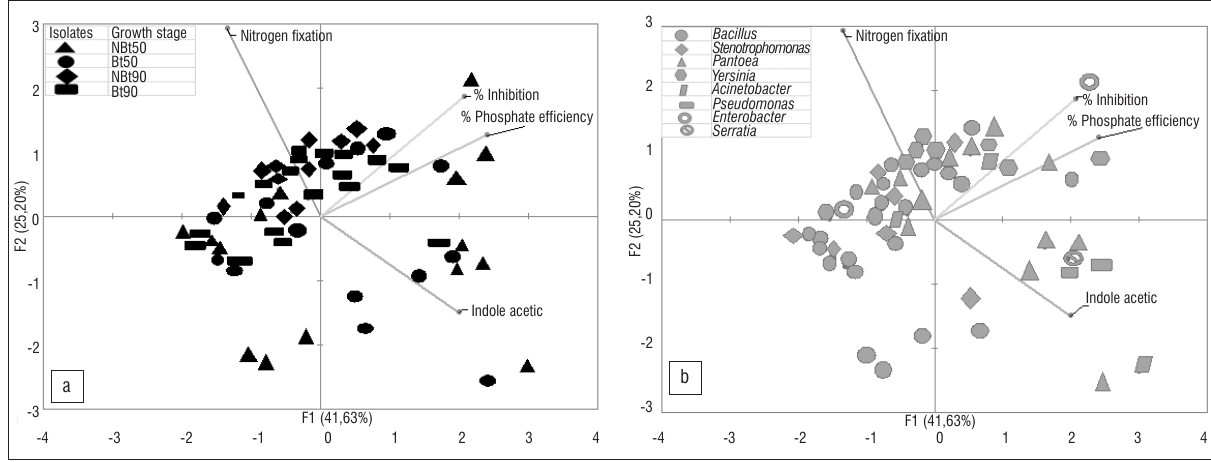
Figure 5: Clustering relationship between (a) endophytic isolates and (b) microbial genera and functional traits based on principal component analysis. (a) The distribution of endophytes isolated from Bt and non-Bt maize varieties at 50 and 90 days. Canonical correspondence analysis ordination diagram with endophytes isolated (circles = Bt 50 days, triangles = non-Bt 50 days, diamond = non-Bt 90 days, rectangles = Bt 90 days) and endophyte function variables (arrows). (b) The distribution of endophytes isolated in Bt and non-Bt maize varieties at 50 and 90 days. Canonical correspondence analysis ordination diagram with endophytes represented by various shapes (circles, triangles, squares, rectangles and diamonds) and endophyte function variables (arrows).